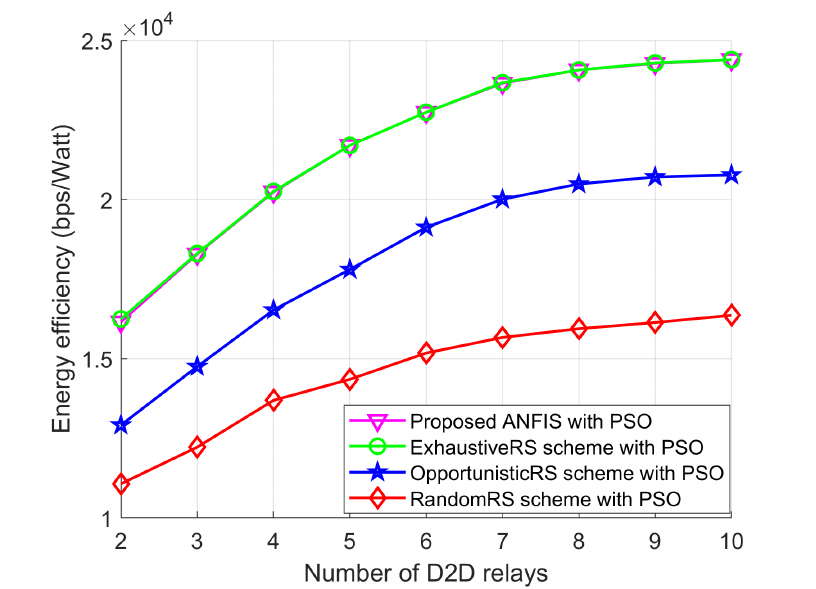
Figure 10. EE performance with L